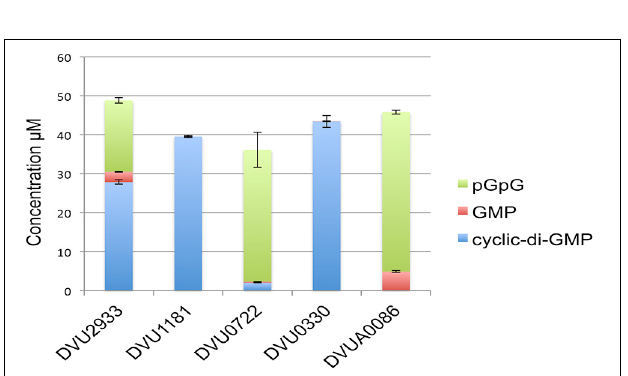
FIGURE 6 | C-di-GMP hydrolysis activity of HD-domain RRs. The graph shows the quantitative measurement of the amount of substrate (c-di-GMP) and products (pGpG and GMP) determined by HILIC-TOF MS analysis that were formed after incubation of isolated HD domains of each RR (7–10 μ g) with 100 μ M c-di-GMP. Concentrations were obtained by comparing peak areas to that of a standard curve. Error bars indicate standard deviations ( n = 3 ).